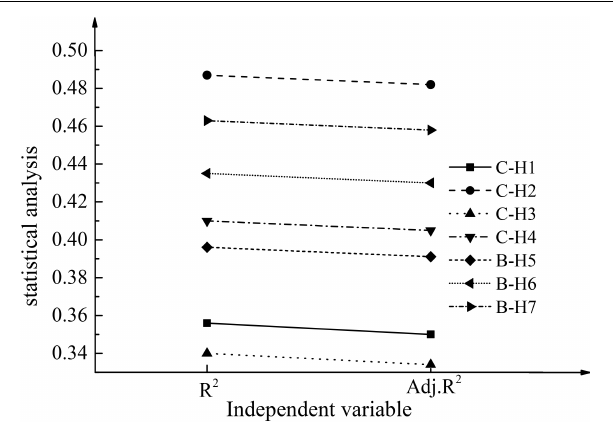
FIGURE 5 | Results of linear regression analysis. C-H1 in the figure represents the R 2 and Adj.R 2 values corresponding to entrepreneurial performance under H1; the rest may be deduced by